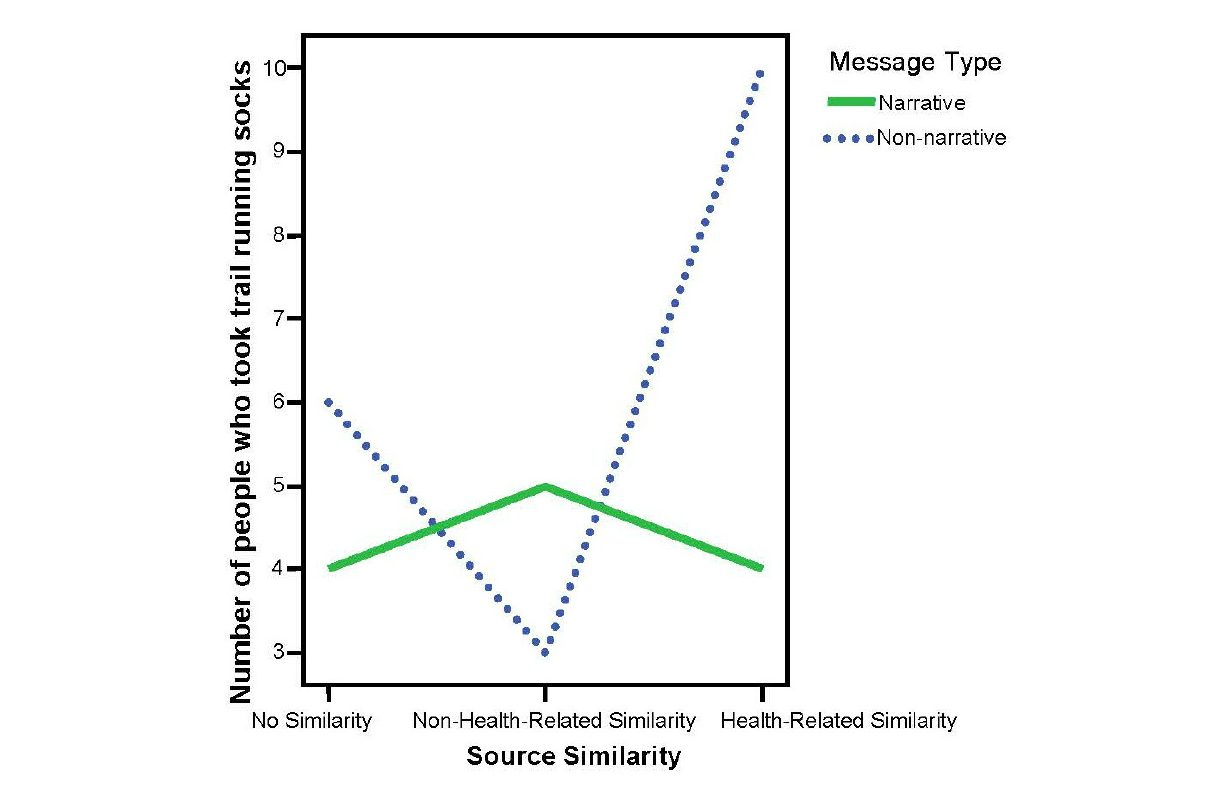
Figure 6. Interaction of message type and source similarity on health-related gift